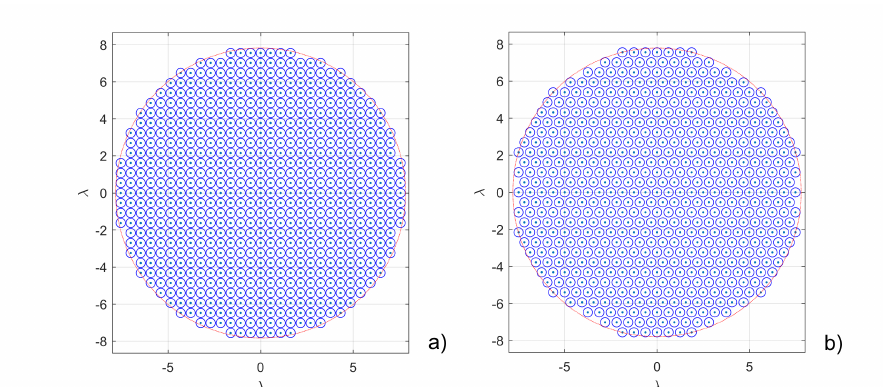
Figure 1. Uniform lattices comparison. ( a ) Square, ( b ) triangular. The blue circles describe the radiating element positions, the red curve represents the limit circle of radius R MAX